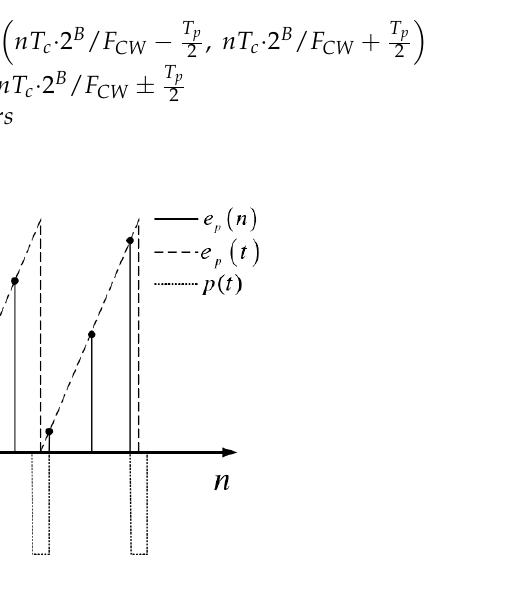
Figure 6. Phase truncation error sequence.